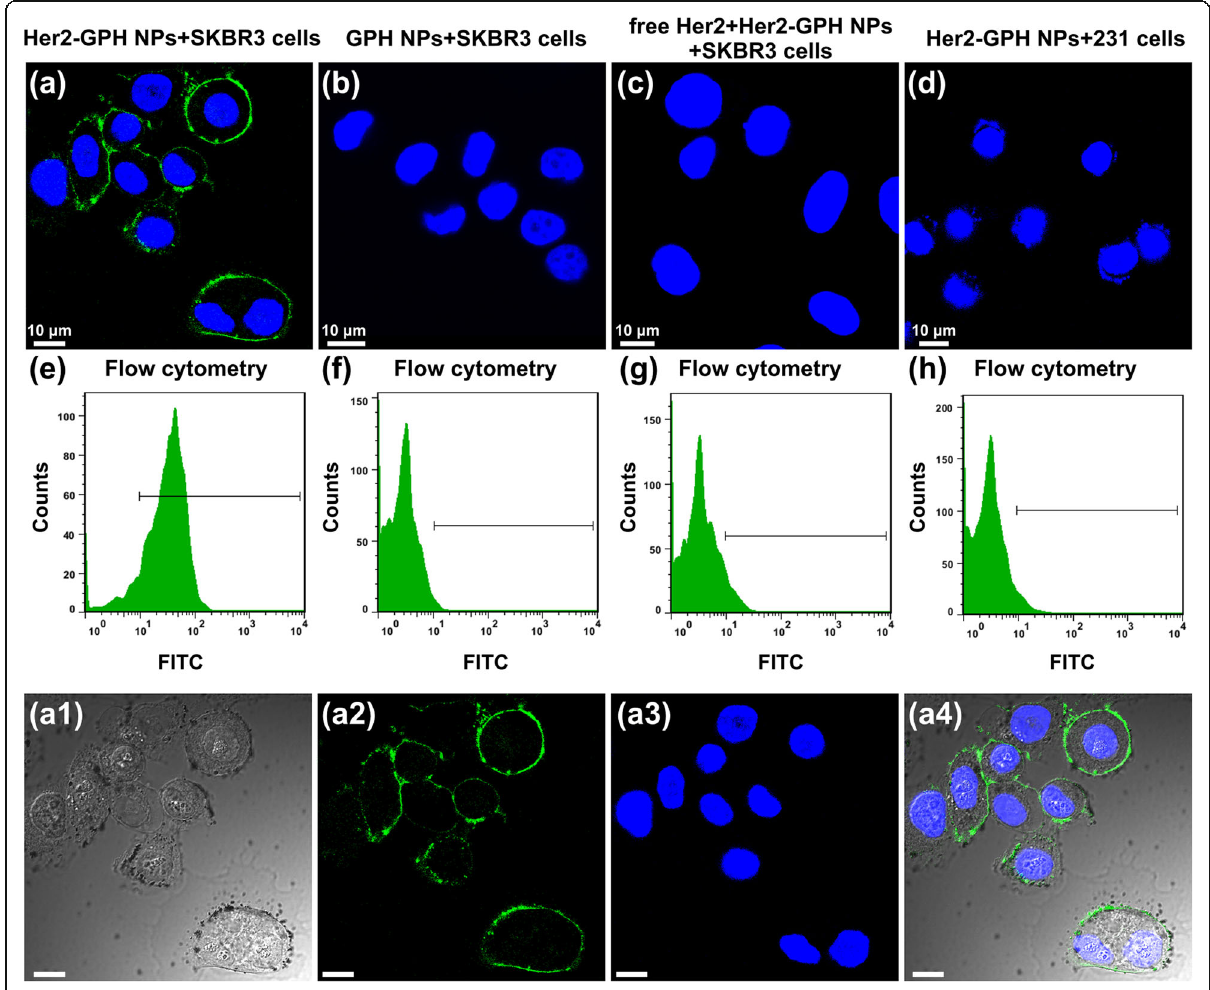
Fig. 7 Confocal microscopic images and flow cytometry results of SKBR3 cells incubated with targeted Her2-GPH NPs ( a / a1 – a4 , e ) and non-targeted GPH NPs ( b , f ), free Her2 antibody pre-treated SKBR3 cells incubated with Her2-GPH NPs ( c , g ), and MDA-MB-231 cells incubated with Her2-GPH NPs ( d , h ). a1 the image of bright field; a2 the image of DAPI channel; a3 the image of FITC channel; and a4 the image of merged channel (scale bar=10 μ